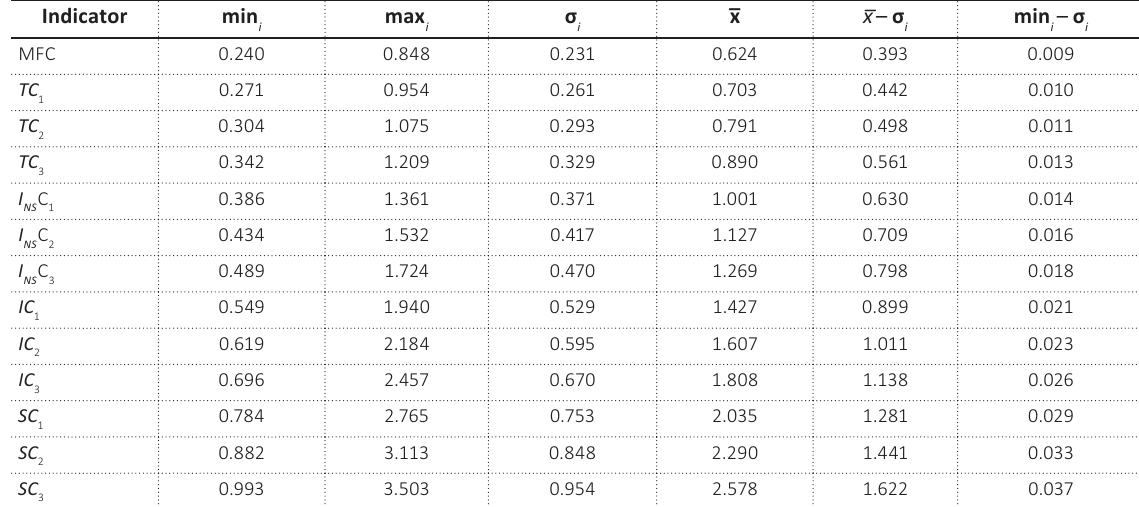
Table 7. Statistical analysis of the most influential determinants of tax, investment, institutional, social channels of the shadow economy and the level of macro-financial stability of Slovenia Indicator